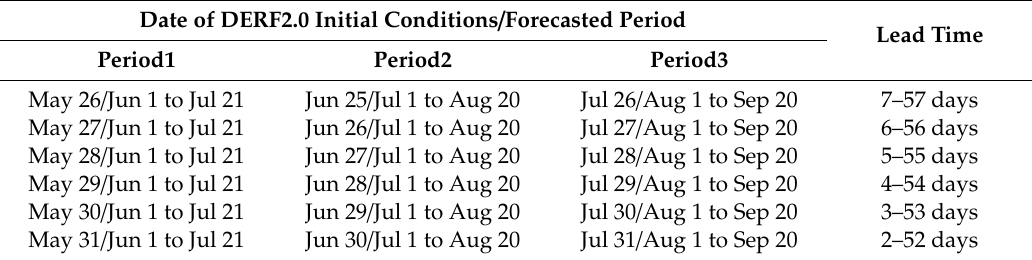
Table 1. DERF2 operation date / forecasted periods and ensemble members lead times. Date of DERF2.0 Initial Conditions / Forecasted